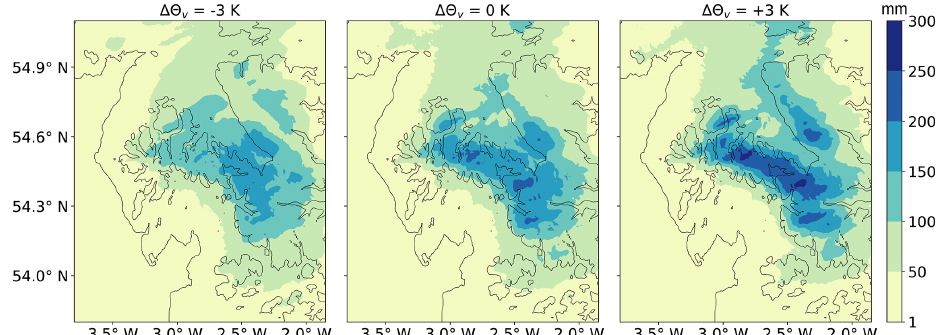
Figure 4. The 24h (5 December 2015, 10:00UTC, to 6 December 2015, 10:00UTC) accumulated rainfall for three PB- T -500 simulations. Black contours indicate the orography at 1m, 250m and 500ma.s.l.